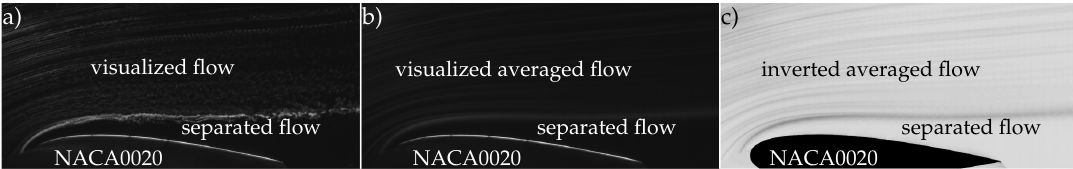
Figure 9. Example of the post-processing procedure for the flapless airfoil at α = 20°; ( a ) snapshot of the visualized flow; ( b ) averaged flow field; ( c ) inverted averaged flow field with mask for the NACA0020 profile.